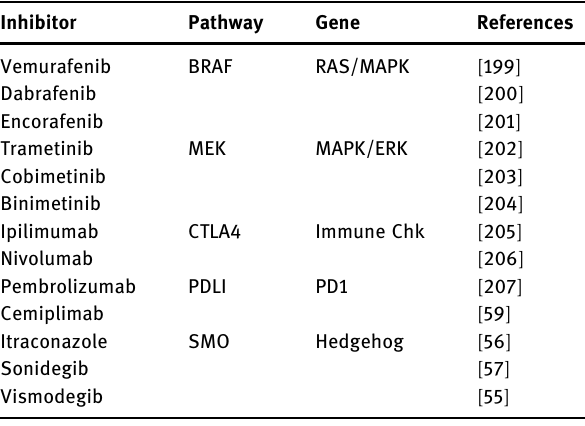
Table 1: Chemical compounds used in SC and their biopathway inhibitors ’ molecular targets Inhibitor